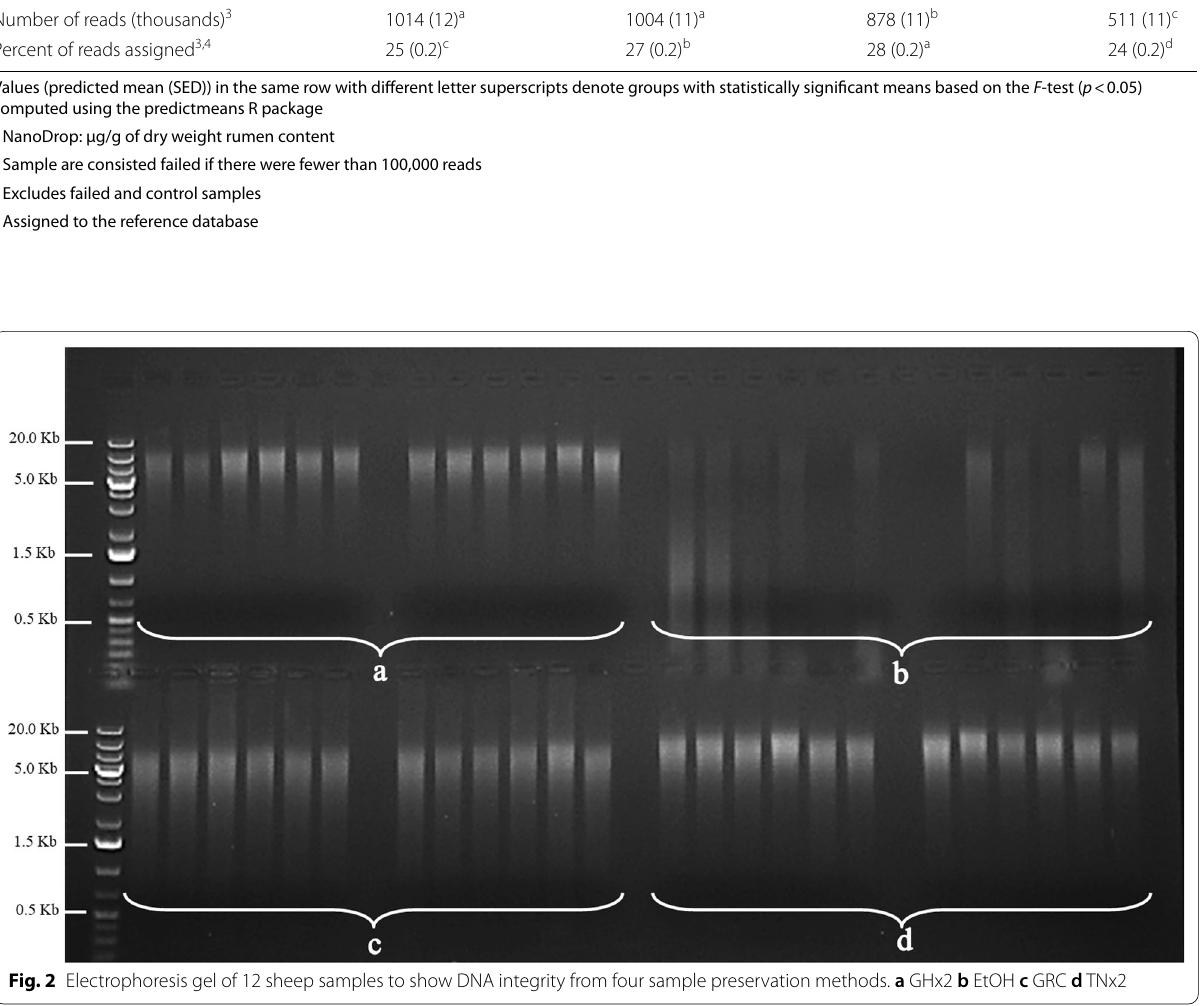
Fig. 2 Electrophoresis gel of 12 sheep samples to show DNA integrity from four sample preservation methods. a GHx2 b EtOH c GRC d